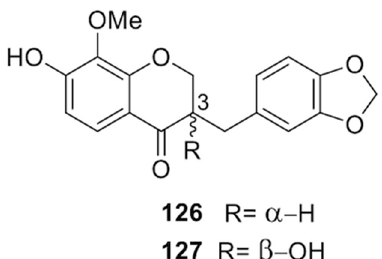
Figure 21. Chemical structures of compounds 126 and 127 isolated from S. trifasciata.